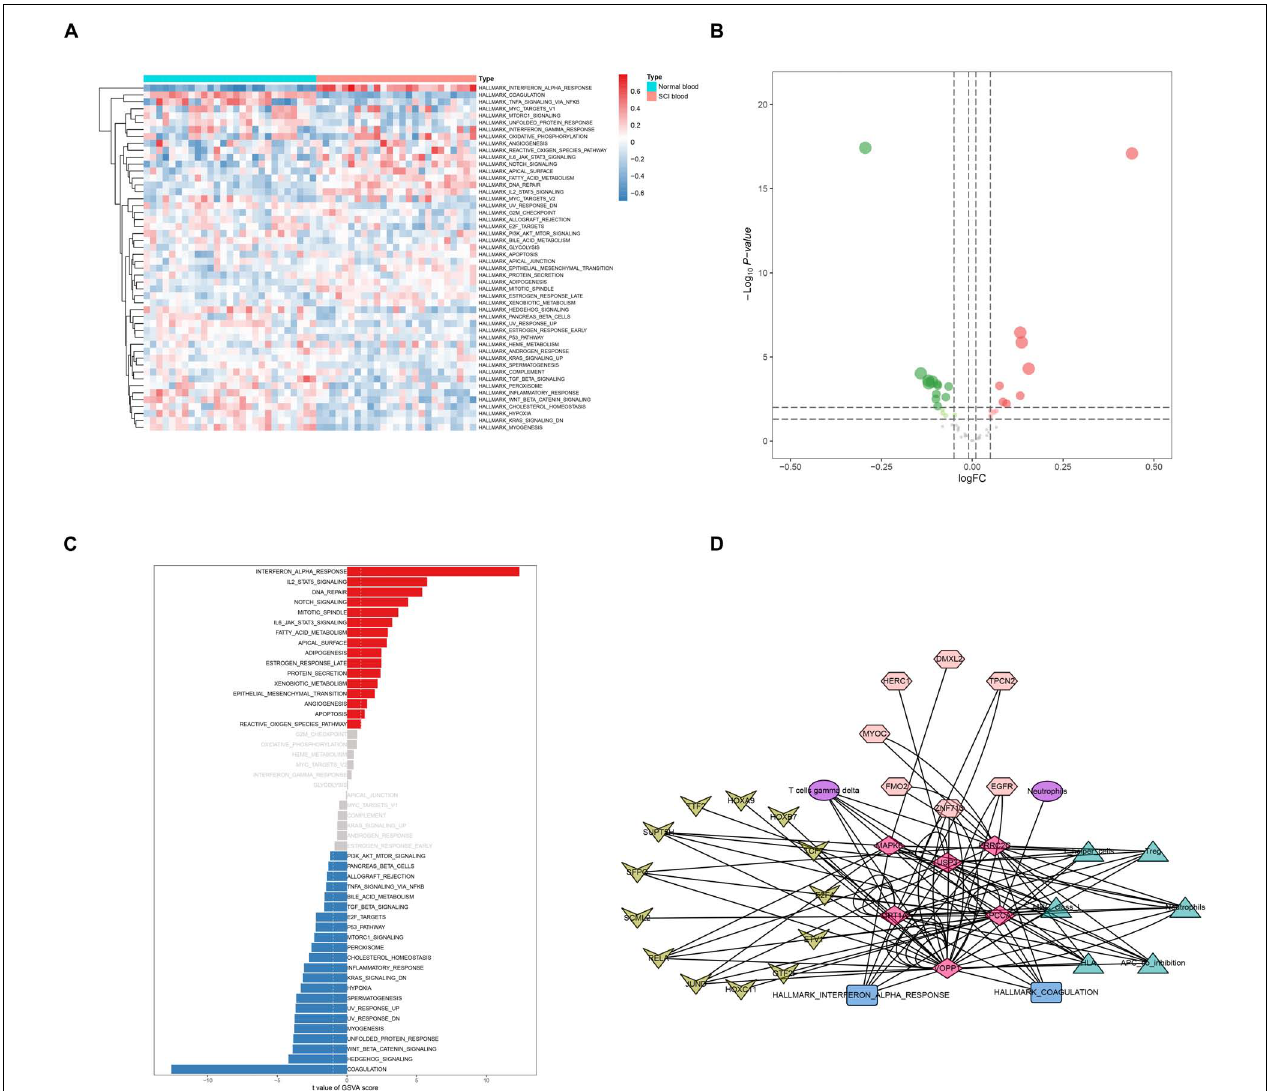
FIGURE 5 | Identification of key hallmark pathways. (A) Heat map showing the co-expression level of hallmark sets in spinal cord injury (SCI) samples by Gene Set Variation Analysis (GSVA). (B) Volcano plot showing the co-expression level of hallmark sets in SCI samples by GSVA. (C) The bar plot revealing the t -value of GSVA score. (D) Overview of the protein–protein interaction network of OA-related enhancer RNAs (eRNAs), translational factors (TFs), immune cells/pathways, and hallmark gene sets. The diamonds represented key eRNAs. The arrows represented TFs. The ellipses represented immune cells. The triangles represented immune pathways. The hexagons represented target genes. The rectangle represented hallmark gene